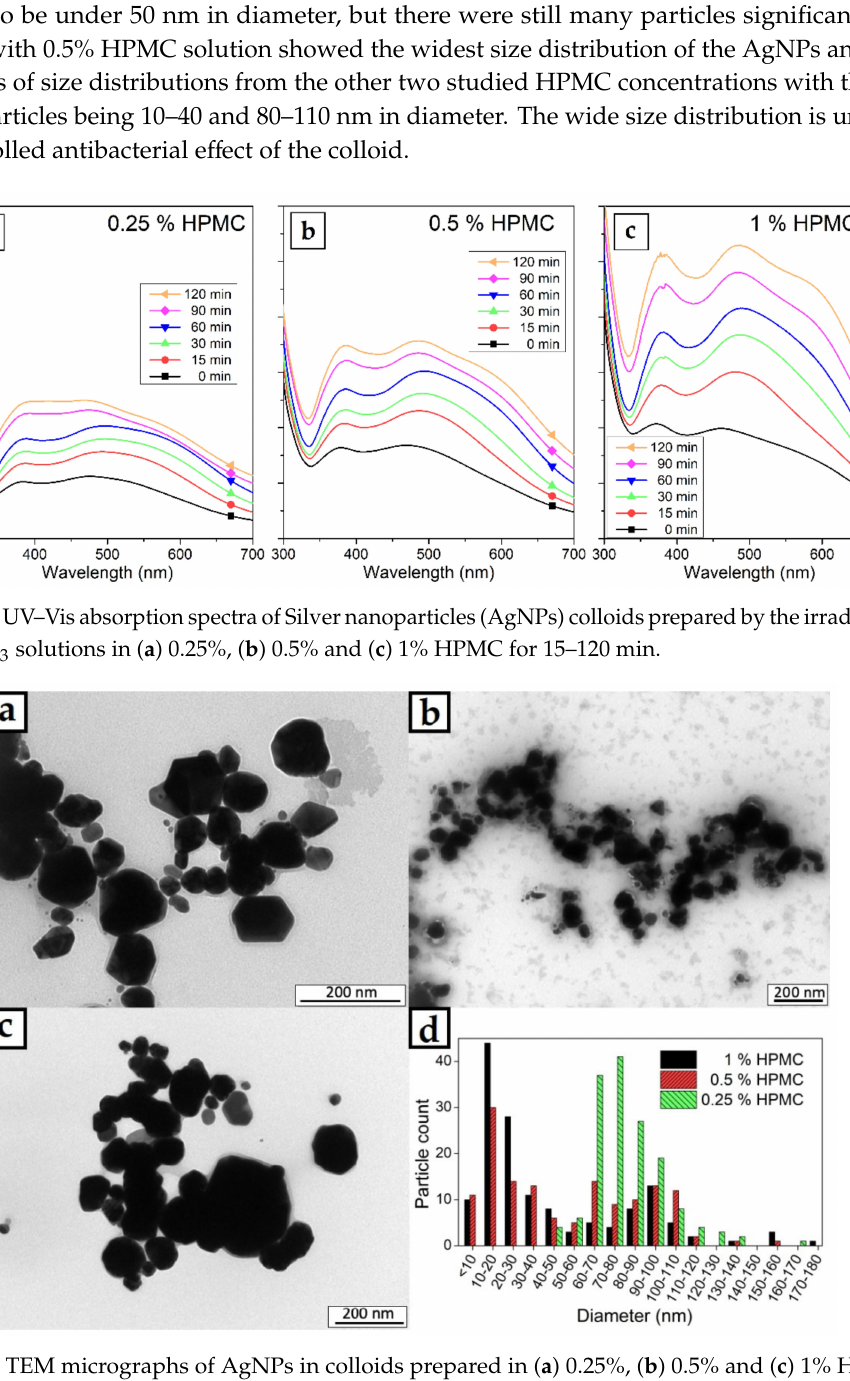
Figure 4. TEM micrographs of AgNPs in colloids prepared in ( a ) 0.25%, ( b ) 0.5% and ( c ) 1% HPMC solutions; ( d ) graph of particle size distributions of the prepared colloid